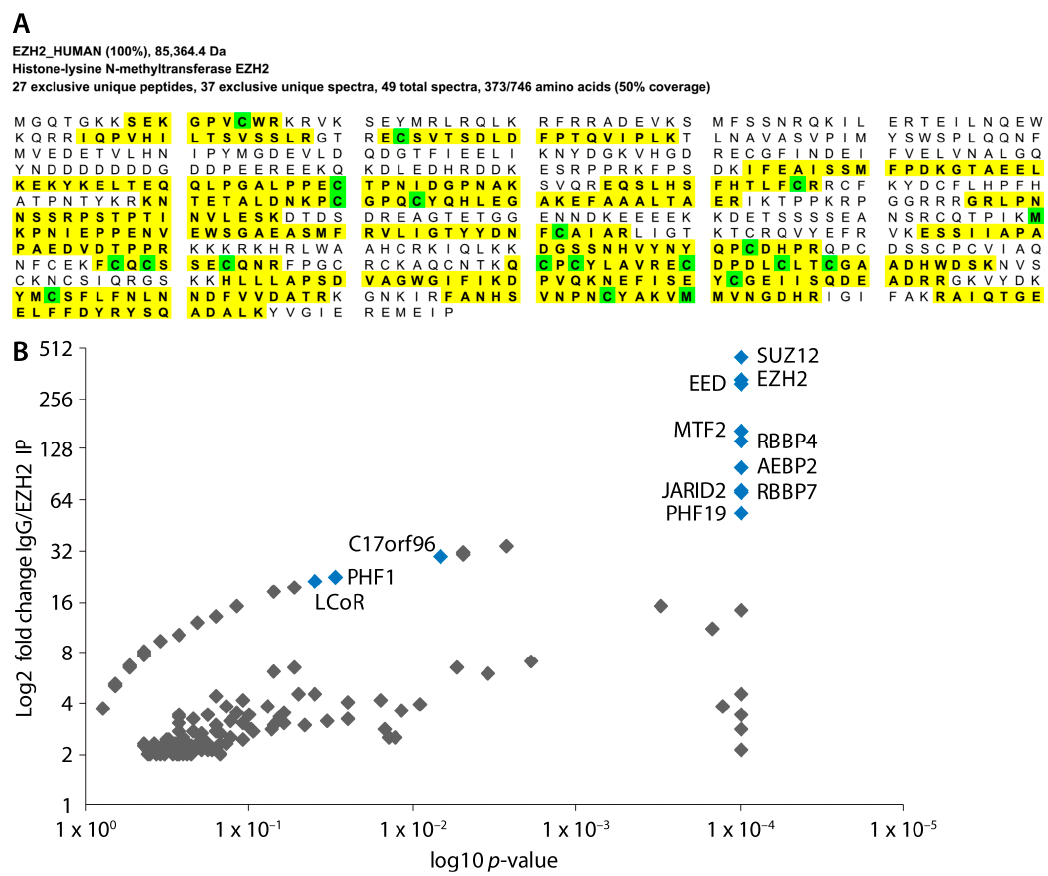
Figure 1. Affinity-purification mass spectrometry coverage of EZH2 and enrichment of PRC2 member proteins. ( A ) Sequence coverage of EZH2 (detected peptides are highlighted in yellow and amino acids with post-translational modifications are shown in green) from a representative mass spectrometry run (peptide threshold 95%); ( B ) Scatter plot of hits from all five mass spectrometry experiments passing a 2-fold change cut-off showing enrichment of core PRC2 components (shown in blue).